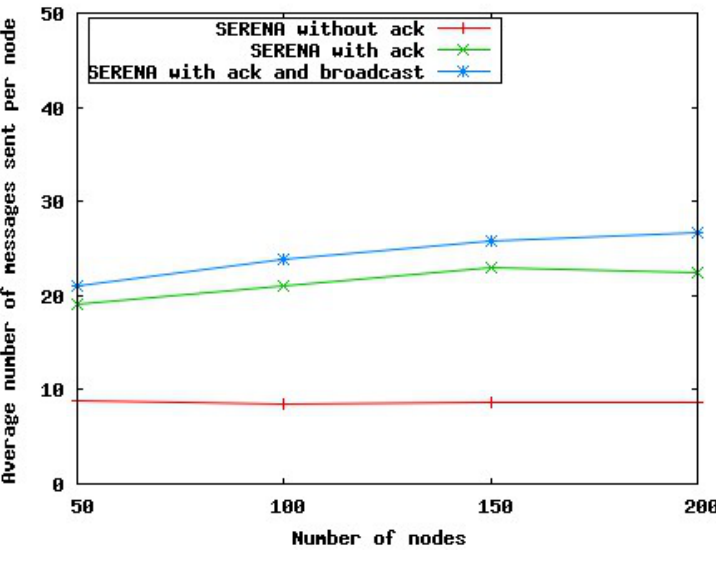
Figure 14. Average number of messages sent per node in a